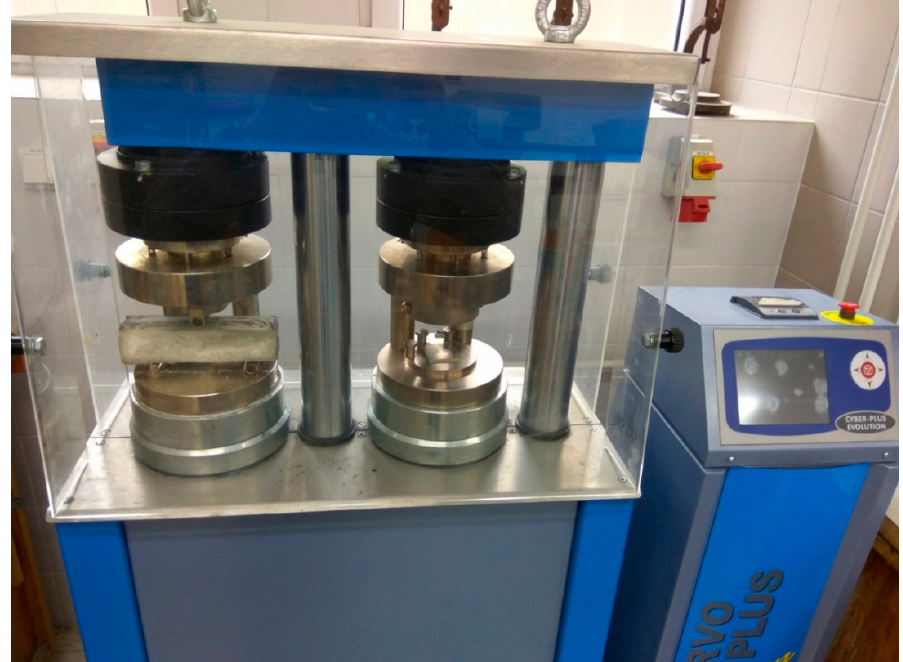
Figure 11. Hydraulic press Servo-Plus Evolution E183.